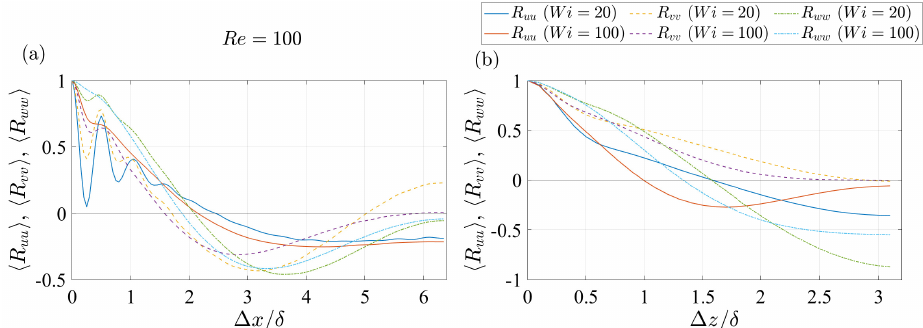
Figure 10. Two-point correlations as a function of ( a ) the streamwise distance ∆ x and ( b ) the stream- wise distance ∆ z are the same as in Figure 9, but for Re =